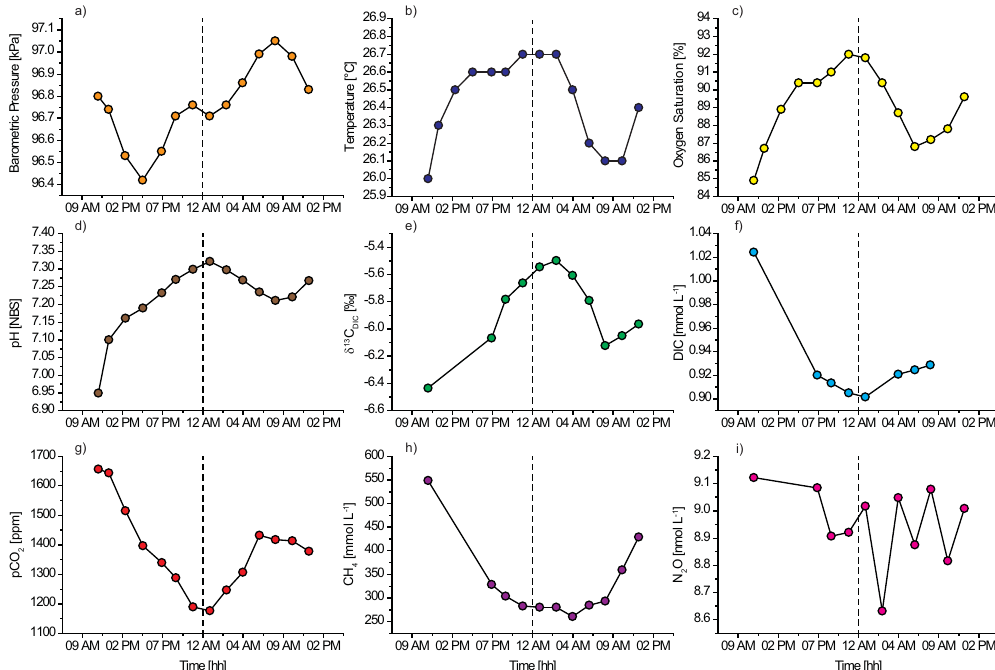
Figure 8. Diel variations of (a) barometric pressure, (b) temperature, (c) dissolved oxygen saturation (%DO), (d) pH, (e) isotopic signature of dissolved inorganic carbon ( δ 13 C DIC ) , (f) dissolved inorganic carbon concentrations (DIC), (g) partial pressure carbon dioxide ( p CO 2 ) , (h) methane (CH 4 ) , and (i) nitrous oxide (N 2 O) measured at ZBZ.11 between 22 and 23 November